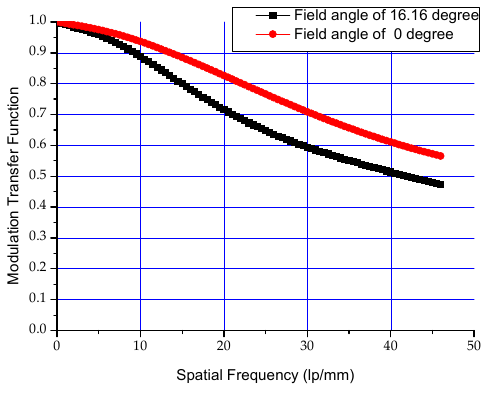
Figure 5. Modulation transfer function curves of the optical system.